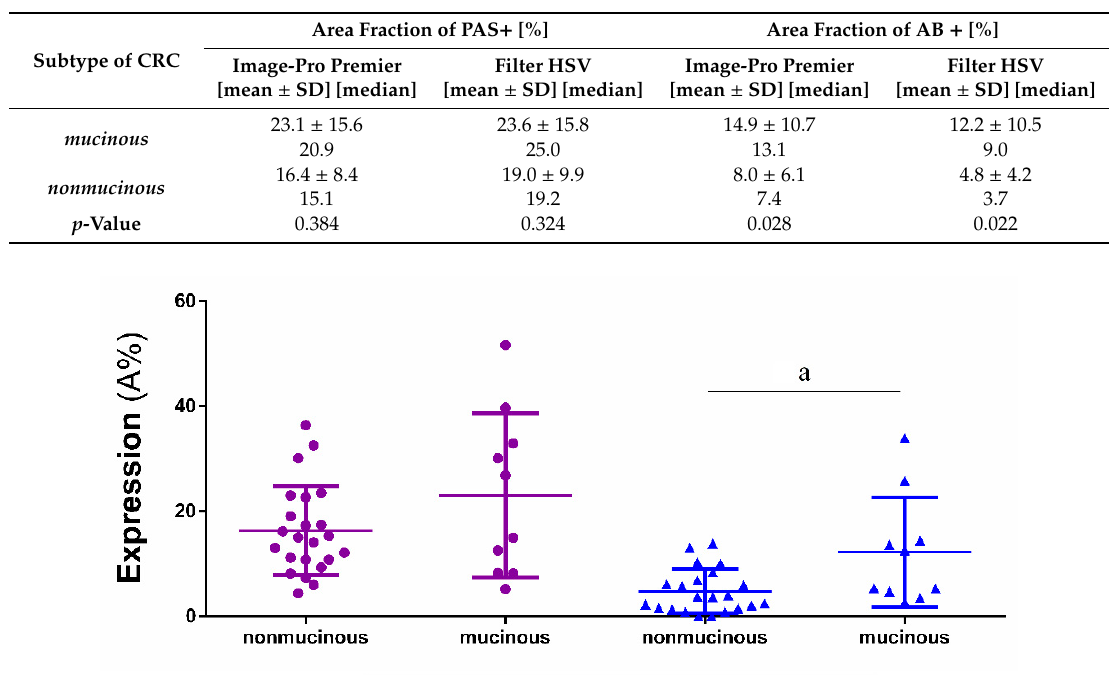
Table 3. Comparison of PAS + and AB + polysaccharides expression in mucinous and nonmucinous subtypes of CRC (A%).